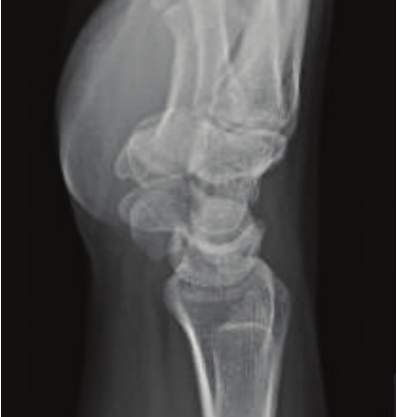
Figure7:Alateralradiographicviewobtainedat6weeksafterinitial presentation showing a normal appearing